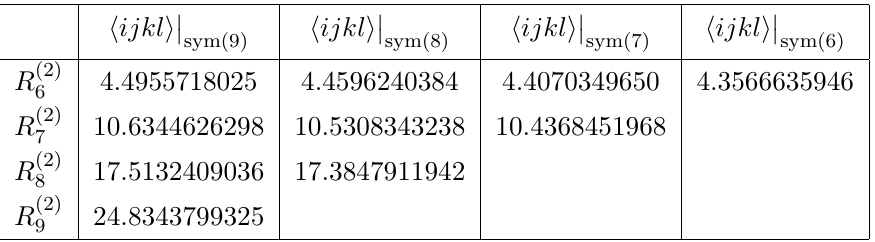
Table 2. The n -point remainder function evaluated at the totally dihedral point h ijkl i n ≤ n 0 ≤ 9